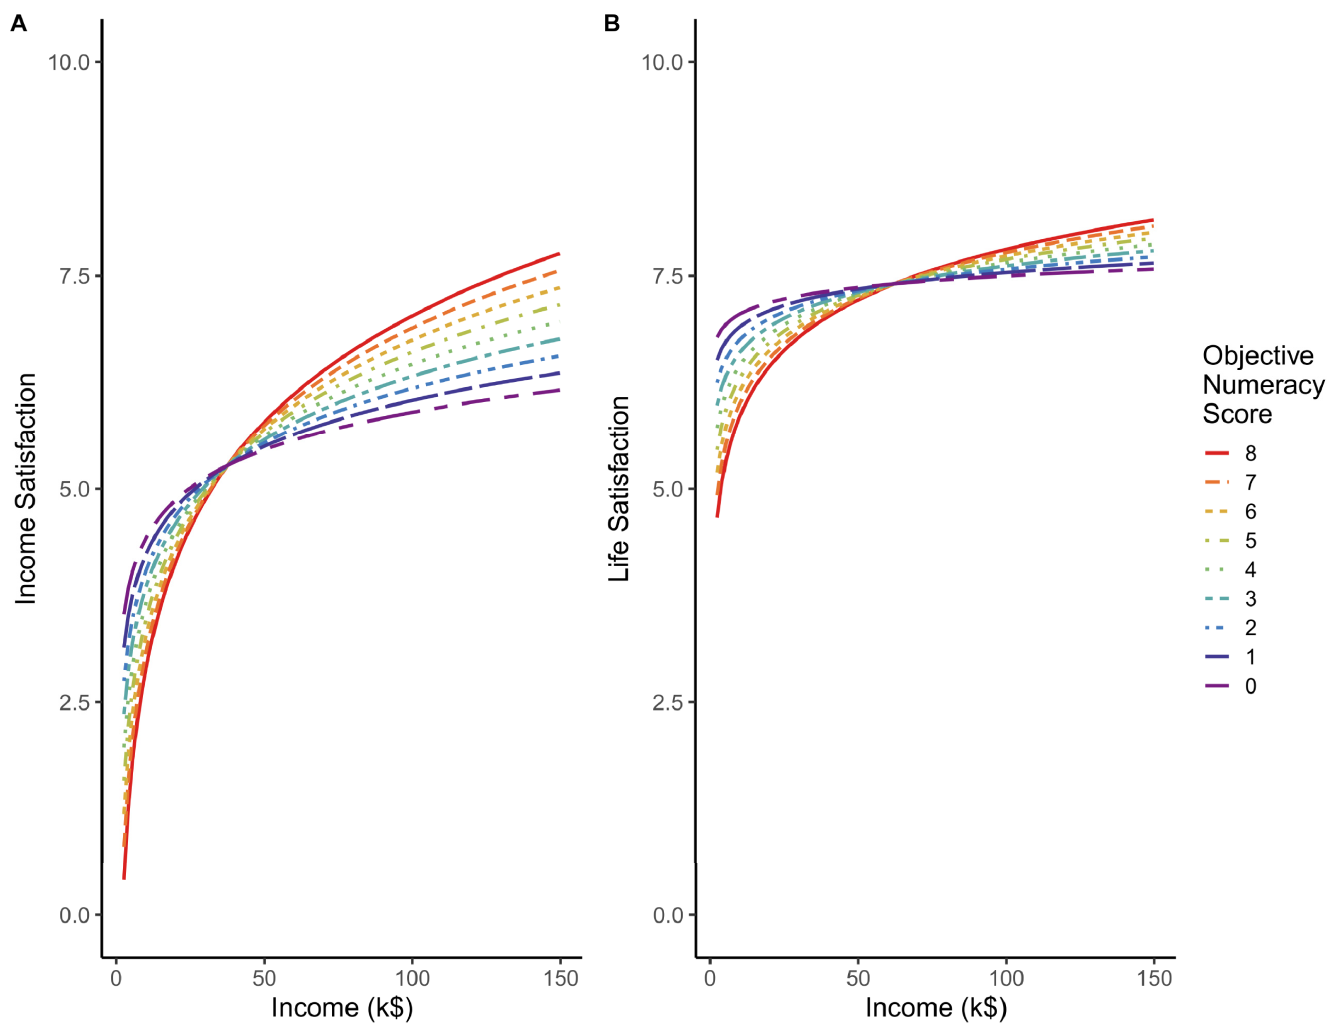
Fig 2. Estimated means of income satisfaction (panel A) and life satisfaction (panel B), plotted as a function of income (thousands of $) and objective numeracy (percentile). The graph indicates that the relation between income and satisfaction is stronger in those with higher numeracy compared to those lower in numeracy, for both income satisfaction and life satisfaction. Thus, numeracy seems to be an important factor when predicting the point of income satiation at the individual